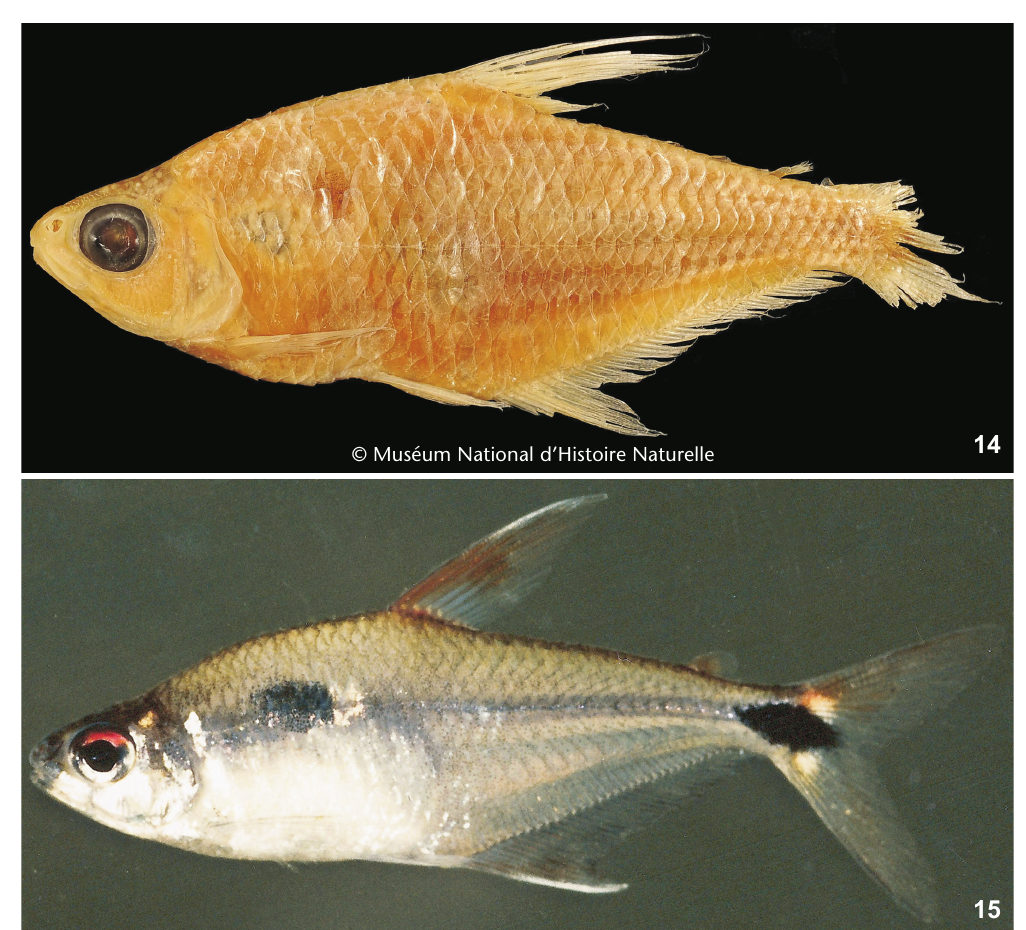
Figuras 14-15. Phenacogaster wayampi sp. nov. : (14) MNHN 1999-1457, holótipo, 47,6 mm CP, Rio Oiapoque, Guiana Francesa; (15) exemplar vivo capturado no Rio Oiapoque, Guiana Francesa. Foto P.